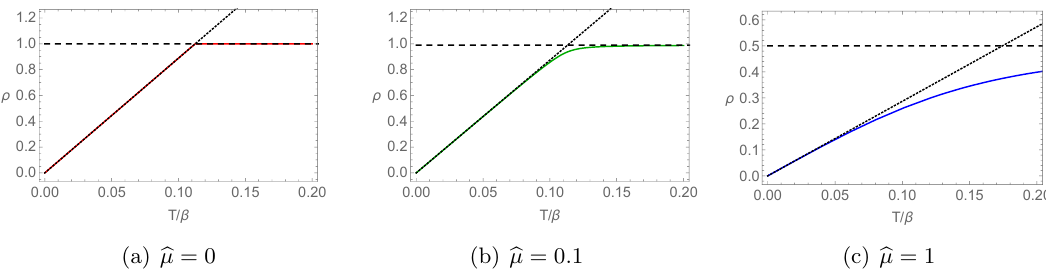
Figure 6 . Resistivity vs temperature at (cid:12)xed and the dotted lines are